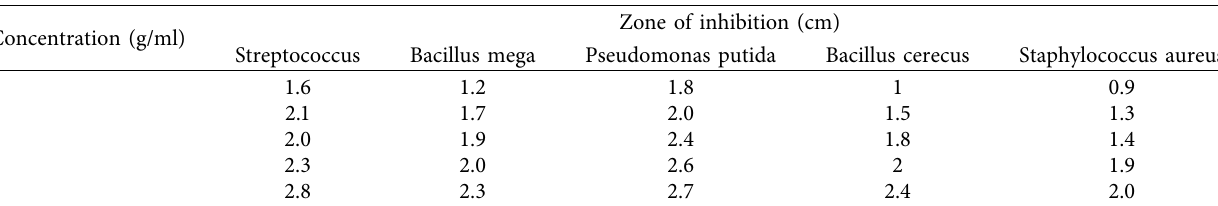
Table 6: Zone of inhibition by agar diffusion method.